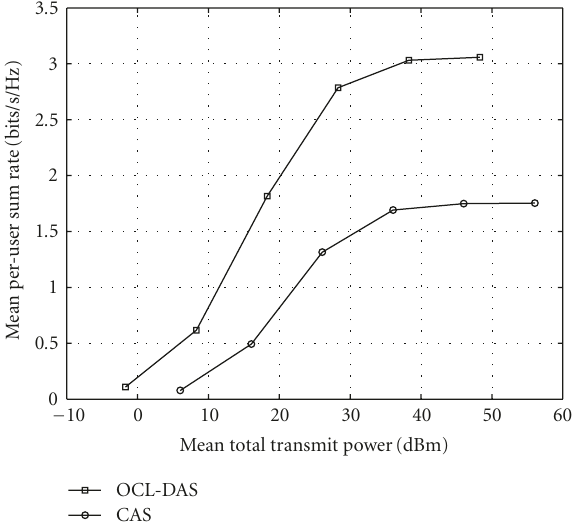
Figure 6: Performance of OCL-DAS in a multicell environment ( N = K =